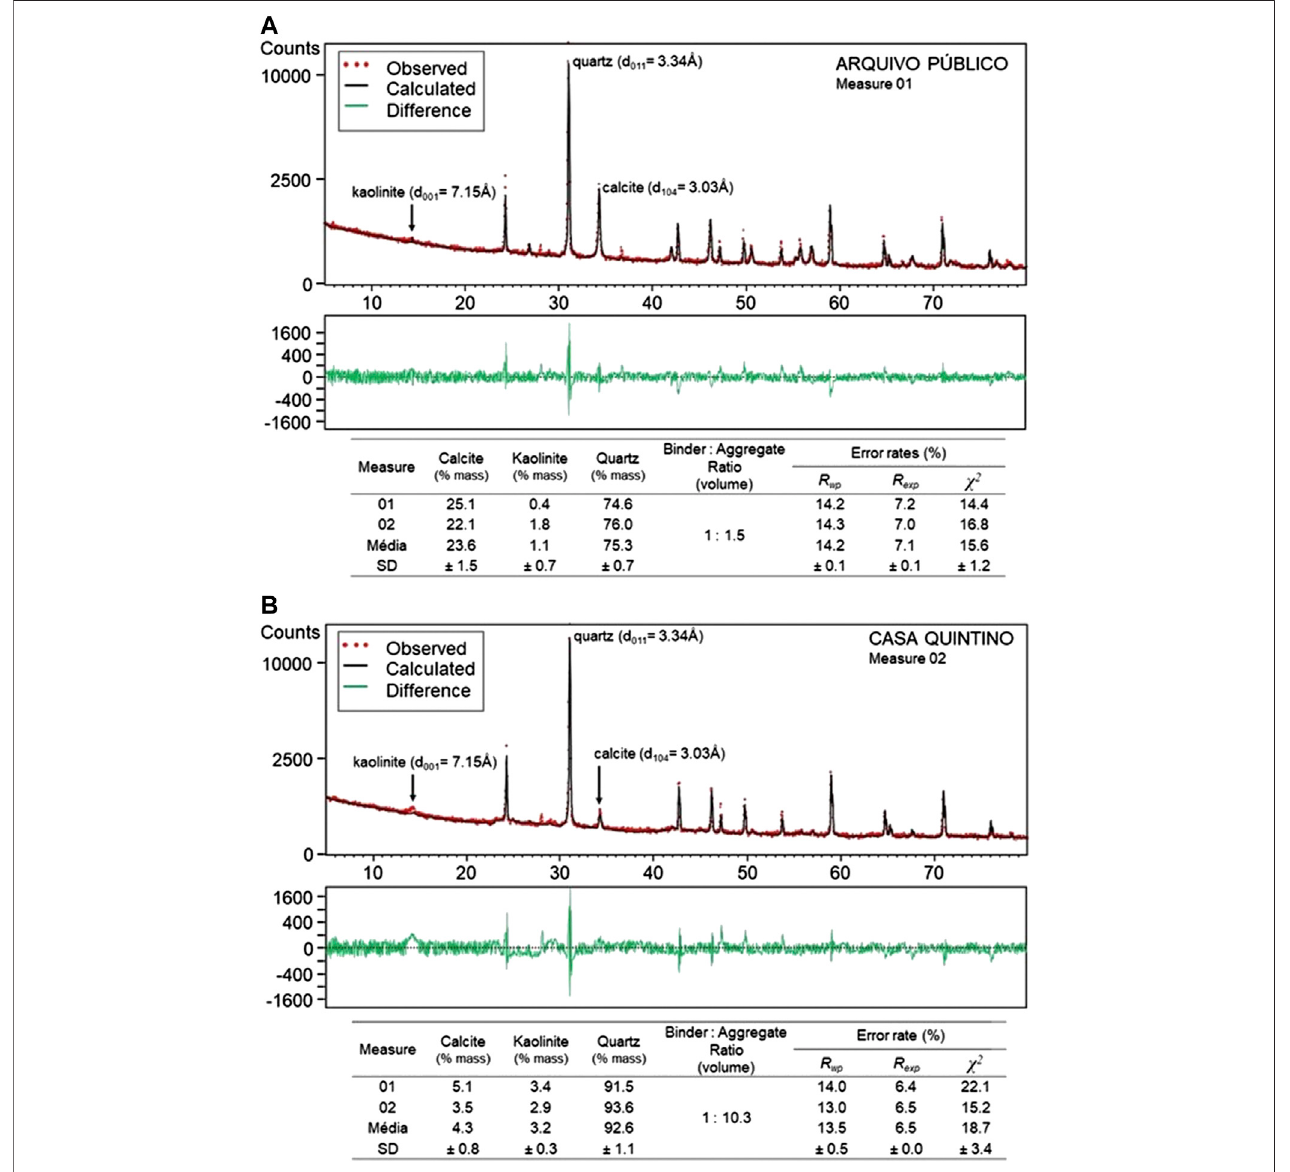
FIGURE 3 | Diffractogram of historic mortars and the content of each mineral identified: (A) Arquivo Público and (B) Casa Quintino.